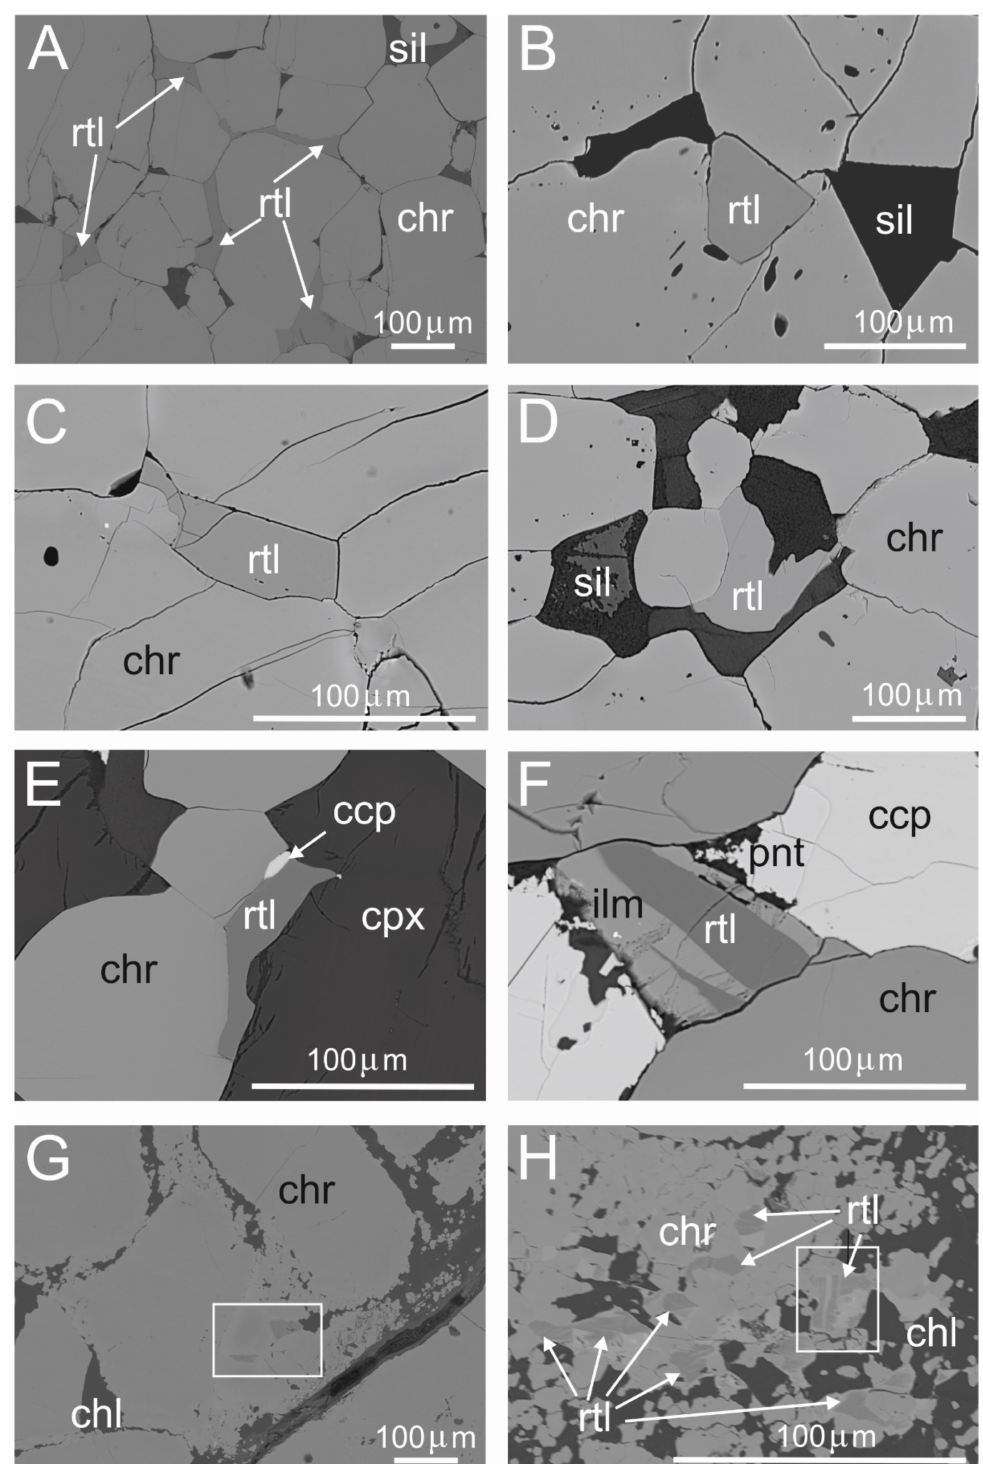
Figure 5. Texture typology of rutile associated with magmatic chromite deposits (BSE images). Net-textured rutile molded on cumulus chromite grains (UG2 chromitite) ( A ). Anhedral rutile interstitial to cumulus chromite (Jacurici samples JC135 and JC126) ( B , C ). Anhedral rutile locked in a silicate pocket interstitial to chromite (Jacurici sample JC135) ( D ). Rutile overgrowing chromite at the contact with clinopyroxene (Merensky Reef) ( E ). Rutile flames in ilmenite interstitial to chromite and sulfide aggregates (Merensky Reef) ( F ). Rutile in partially altered massive chromite (Loma Peguera, sample LP4) ( G ). Rutile and chromite, both replaced by ilmenite (Loma Peguera, sample LP4) ( H ). Boxes in G and H indicate position of rutile grains. Abbreviations: ccp, chalcopyrite; pnt, pentlandite; ilm, ilmenite; others as in Figure